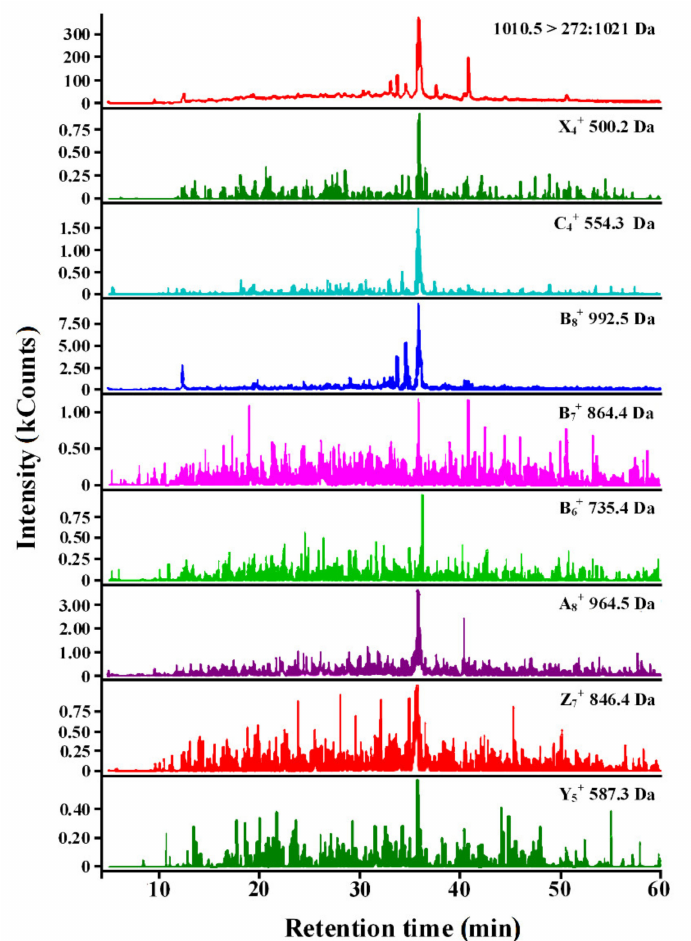
Figure 2. LC-MS / MS (Reversed-Phase High Performance Liquid Chromatography online with tandem Mass Spectrometry) chromatograms of total ion current (upper chromatogram: 1010.5 > 272:1021 Da) and daughter ions of the FFEI TPEK peptide matching the β -conglycinin ( β -chain) fragment, identified among products of the soybean protein concentrate hydrolyzed by ficin. Nomenclature of daughter ions according to Roepstor ff and Fohlman